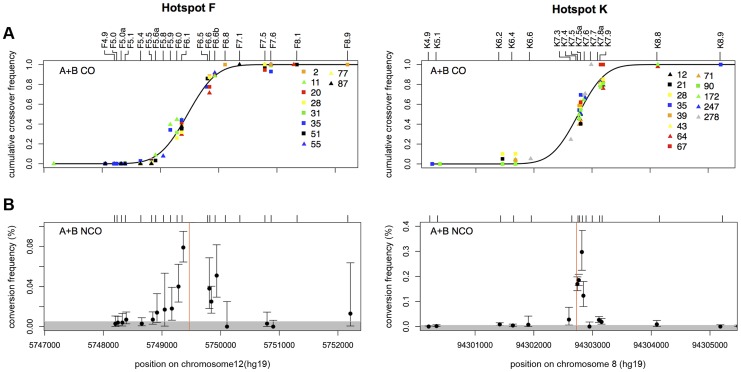
CO and NCO distributions at recombination hotspots F and K.(A) Combined reciprocal cumulative CO distributions. SNP markers across the assay intervals are indicated by tick marks and local names on the top of the box plots (see Table S6 for dbSNP identifiers). Data points represent the observed cumulative proportion of COs pooled from reciprocal assays (A+B COs) at each informative marker for a given man. Different coloured symbols represent different men that are numbered as in refs 5 and 9. A total of 1028 COs were characterised from 10 men at hotspot F (mean CO frequency per sperm 0.81±0.41%) and 599 COs from 13 men at hotspot K (mean CO frequency per sperm 0.26±0.1%). A black line shows the best-fit cumulative CO distribution for each hotspot. (B) NCO gene conversion frequency per SNP, averaged over reciprocal assays (A+B NCOs). Mean conversion frequencies were determined by Poisson-approximation with 95% confidence intervals estimated by simulation. The grey shaded area marks what appears to be a background zone of presumably PCR mis-incorporation that results in false-positive single-SNP NCO artefacts that arise at a frequency of one per ∼15000 progenitor molecules tested. Hotspot centres, as defined by CO distributions, are indicated by red lines. Individual graphs showing the NCO gene conversion frequencies for each man in each orientation can be seen in Figures S1, S2, S3.